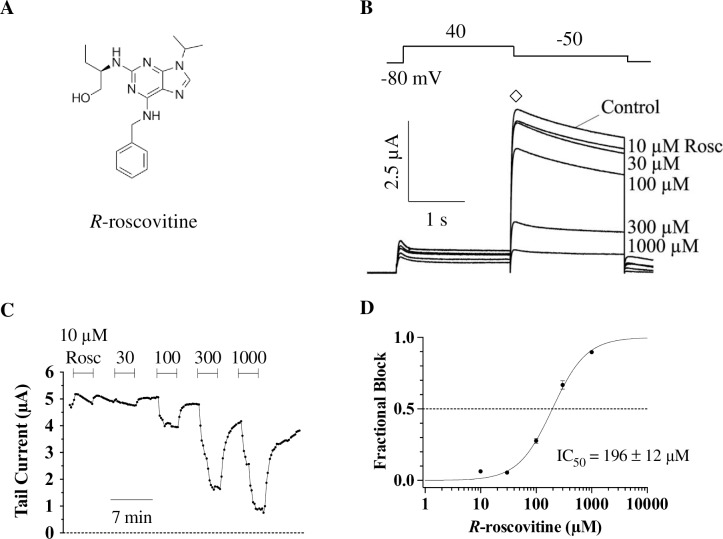
Dose-response curve for R-roscovitine inhibition of WT hERG channels.A) Skeletal formula of R-roscovitine, 2-(1-ethyl-2-hydroxyethylamino)-6-benzylamino-9-isopropylpurine. B) Pulse protocol (top) along with representative traces from a WT cell (bottom) exposed to the indicated R-roscovitine concentrations. Channels were activated with a 1-second step to +40 mV from -80 mV, and tail currents (◊) were elicited by a 1-second repolarization to -50 mV. The single 2-second episodic pulse was repeated for 3.44 minutes as the various concentrations were washed in and out of the gravity-fed perfusion system. C) Time-course of tail current inhibition (measured from ◊, in B) from a representative cell expressing WT hERG in the presence of the indicated R-roscovitine concentrations. D) Fractional block data were fitted with a Hill equation (see methods) to obtain the IC50 for WT hERG (196 ± 12 μM, n = 11). Error bars here and elsewhere represent standard errors.